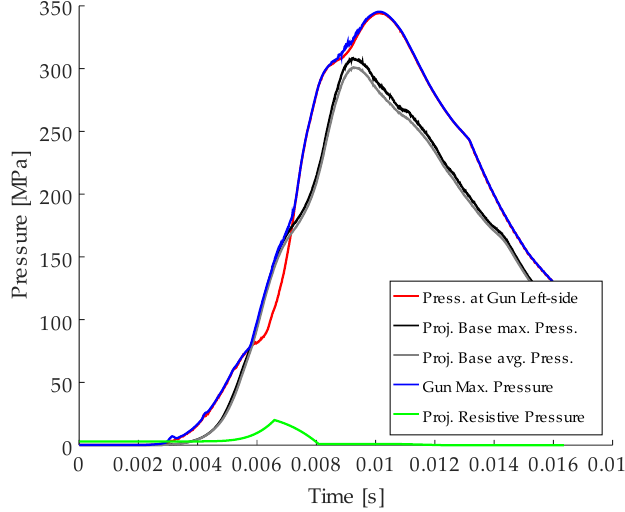
Figure 11. Numerical results for 155/52 six-module charge firing test: Projectile displacement (m) vs. time (s), and projectile velocity (m/s) vs. time (s).